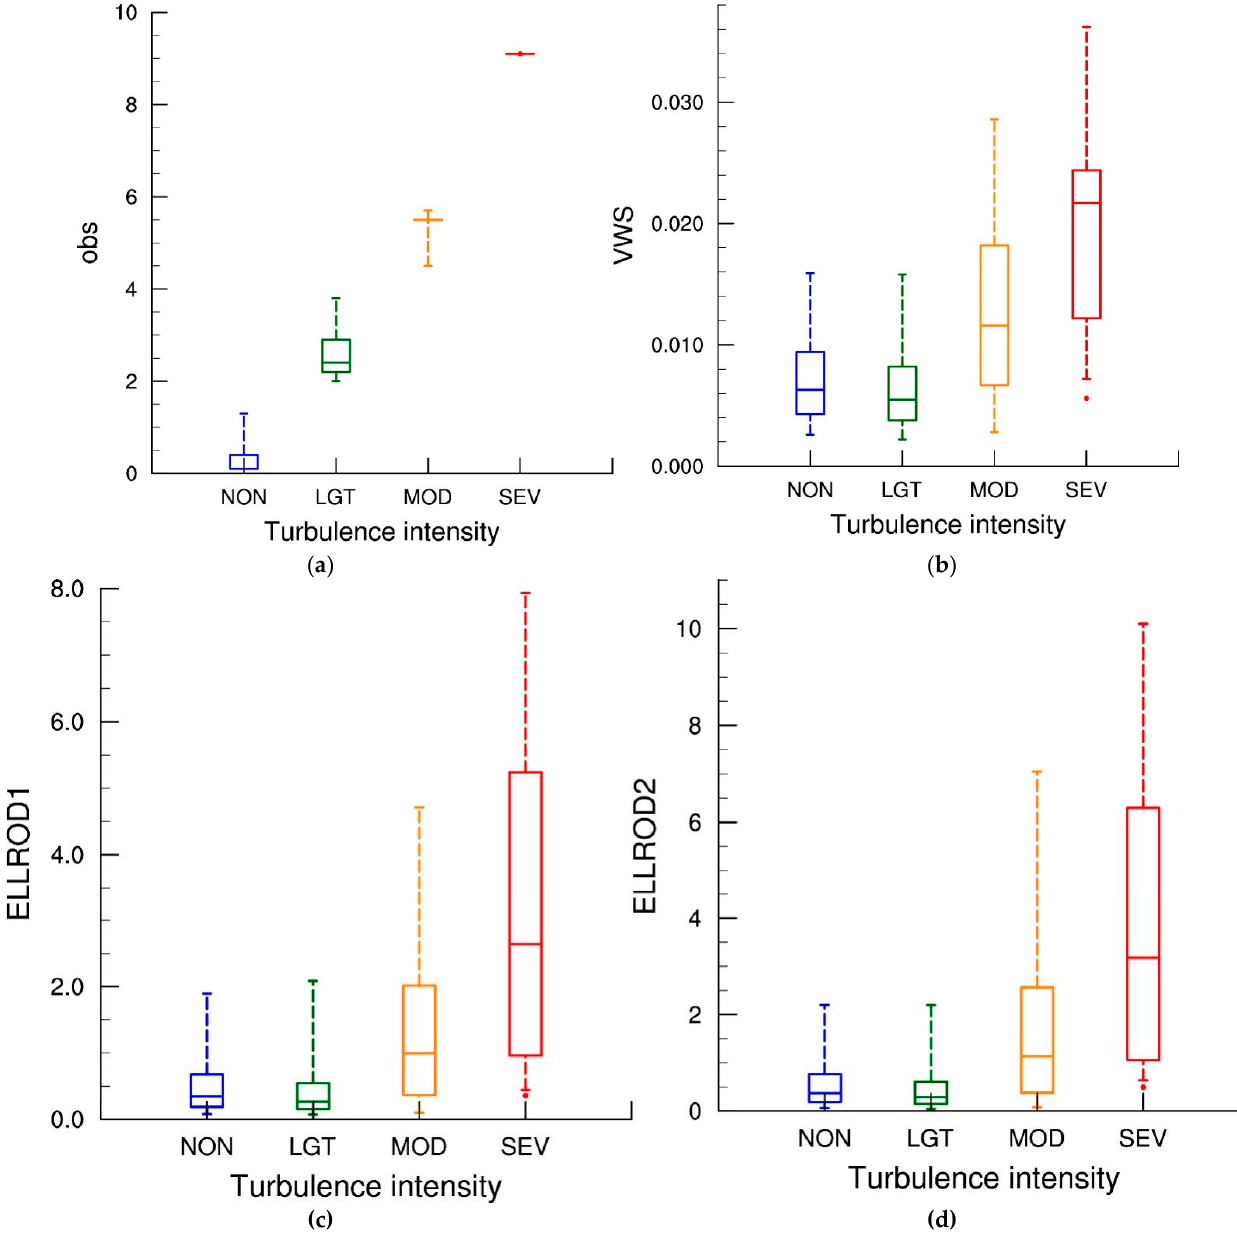
Figure 4. Box-plots of the distribution of: ( a ) turbulence observations (m s − 1 ), ( b ) VWS (s − 1 ), ( c ) ELLROD1 (10 − 6 s − 2 ), and ( d ) ELLROD2 (10 − 6 s − 2 ). These box-plots were constructed for four classes of turbulence (NON, LGT, MOD, and SEV). Statistical parameters in the box-plot are the 95 th and 5 th percentiles (upper and lower tick marks, respectively), 75 th and 25 th percentiles (upper and lower boundaries, respectively), and median (line inside the boxes).